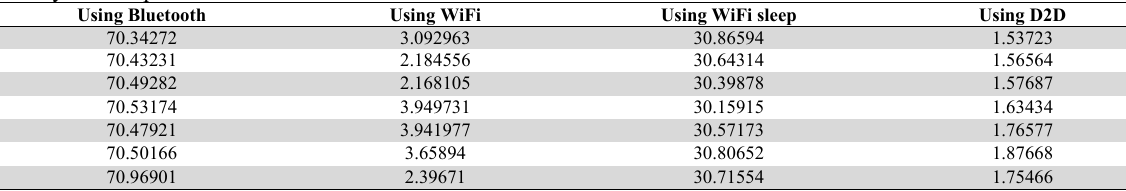
Battery consumption in different scenarios Using